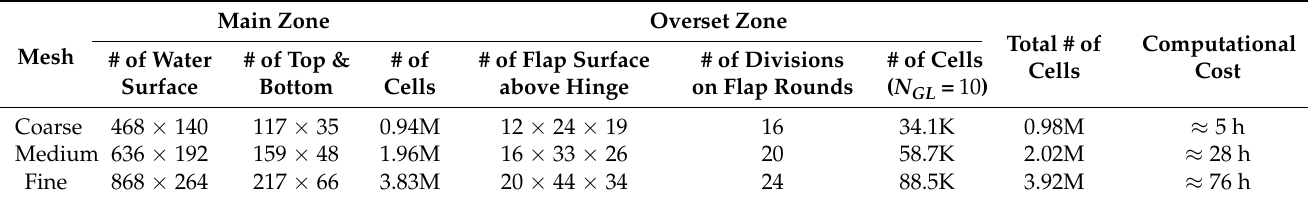
Table 3. The mesh statistics and computation cost (on 16 processors) for three configurations of grids in